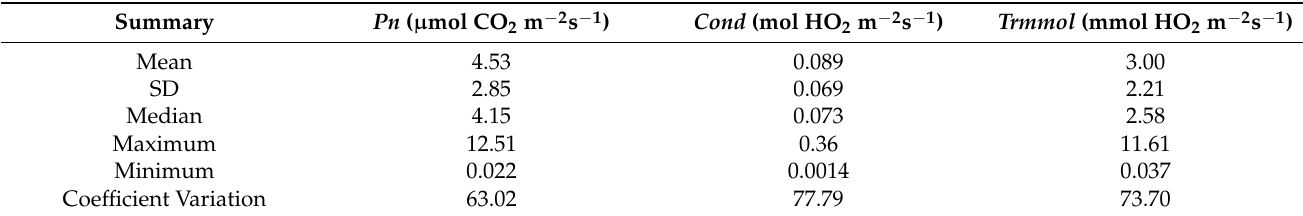
Figure 7. Performance of the spectral parameters for revealing the difference of the four drought treatments. ( a – j ) represent SW1-fwhm-Y1, SW1-fwhm- ∆ λ , SW2-Area, SW1-SAI, SW2-fwhm-Y, GVMI, SW2-fwhm- ∆ λ , SW2-SAI, MSI, and NDWI1640, respectively. Significant differences are indicated by different letters on the histogram at the same time. Table 3. Descriptive data from the photosynthetic parameters’ analysis of the lemon